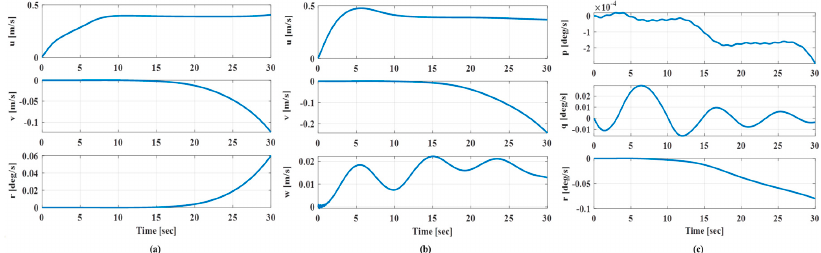
Figure 23. Simulation results of state values of the unmanned ocean platform: ( a ) Linear and angular velocity of the USV; ( b ) Linear velocity of the UUV; ( c ) Angular velocity of the UUV.